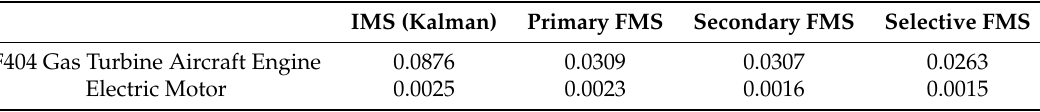
Figure 6. Estimation errors of the proposed selective FMS and primary FMS filters for the F404 gas turbine aircraft engine system. Table 1. Comparison of mean of RMS estimation